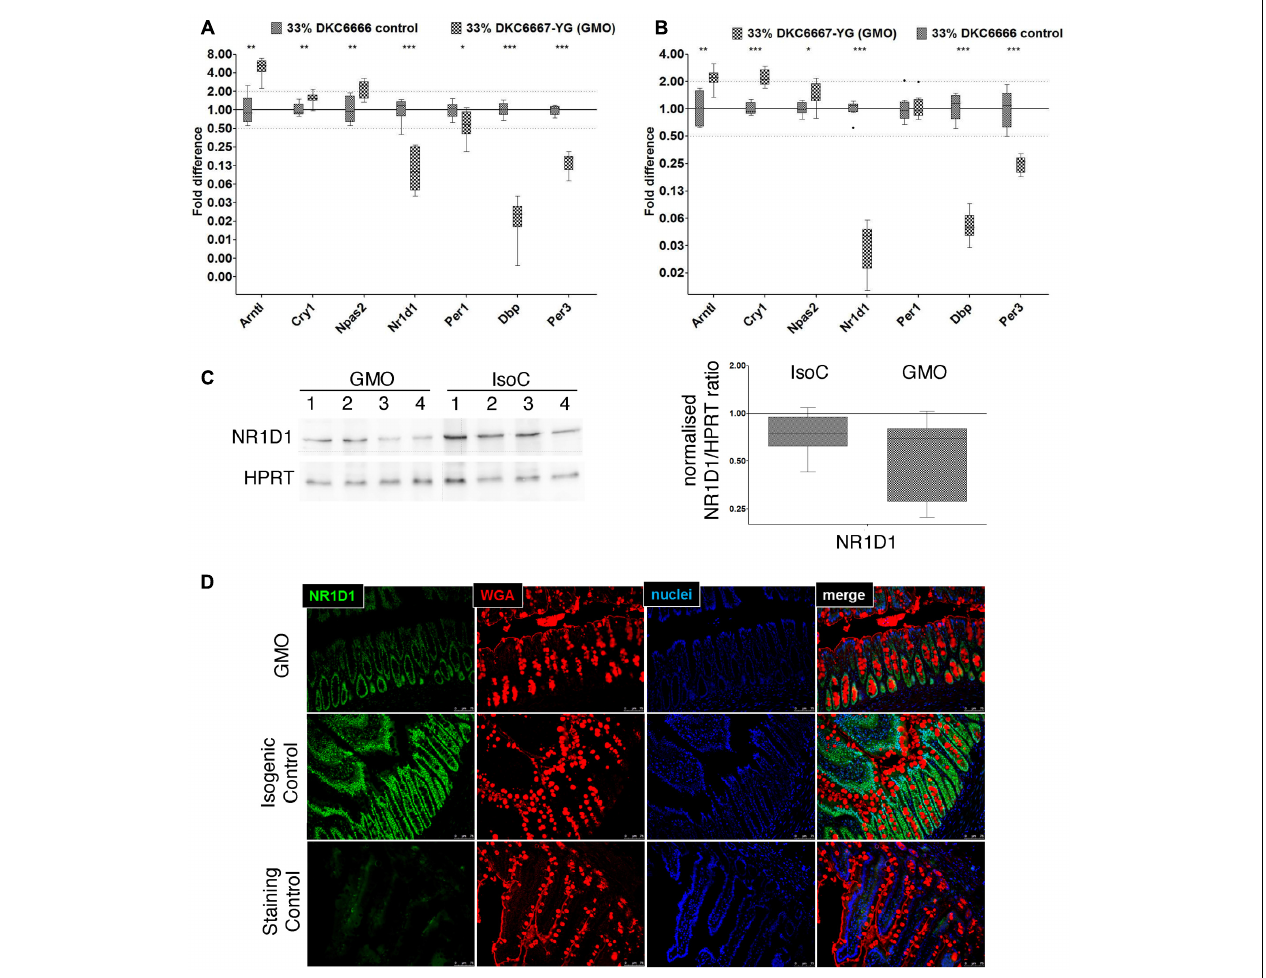
FIGURE 5 | Differential expression of selected core circadian clock genes and NR1D1 protein in ileum. RT-qPCR analysis of circadian clock genes in male (A) and female (B) rats from study A. (C) Representative Western Blot images of NR1D1 in female ileum (left), and densitometric analysis of three replicates of Western blot analyses and of eight biological replicates from each study group (right). When normalized for HPRT protein expression, there was no significant difference between the study groups (D) Immunostaining of NR1D1 protein (green) in small intestinal paraffin embedded tissue sections demonstrates nuclear localization in intestinal epithelial cells (representative image). Wheat germ agglutinin (WGA) immunostaining (red) was used for outlining cell borders and mucus; the blue color indicates staining of nuclei by 4’,6-diamidino-2-phenylindole (DAPI). ∗ P < 0.05; ∗∗ P < 0.01; ∗∗∗ P < 0.001; Mann–Whitney U